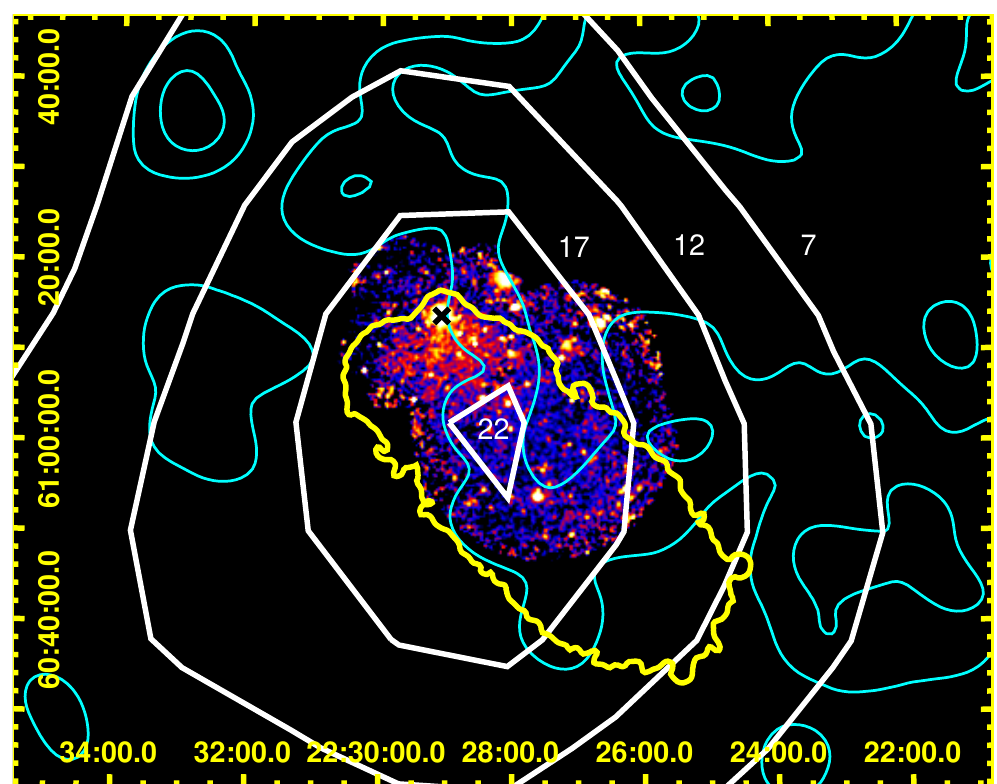
Figure 1. Observation results from different energy bands in equatorial coordinate system. The central-colored part is the combination of the X-ray observation from Chandra and XMM- Newton [8]. The pulsar position is marked with a black cross. The yellow curve outlines the 1.4 GHz radio continuum of the SNR [3]. The cyan contours show the CO emission of the molecular cloud [4]. The white contours show the LHAASO observation with numbers representing